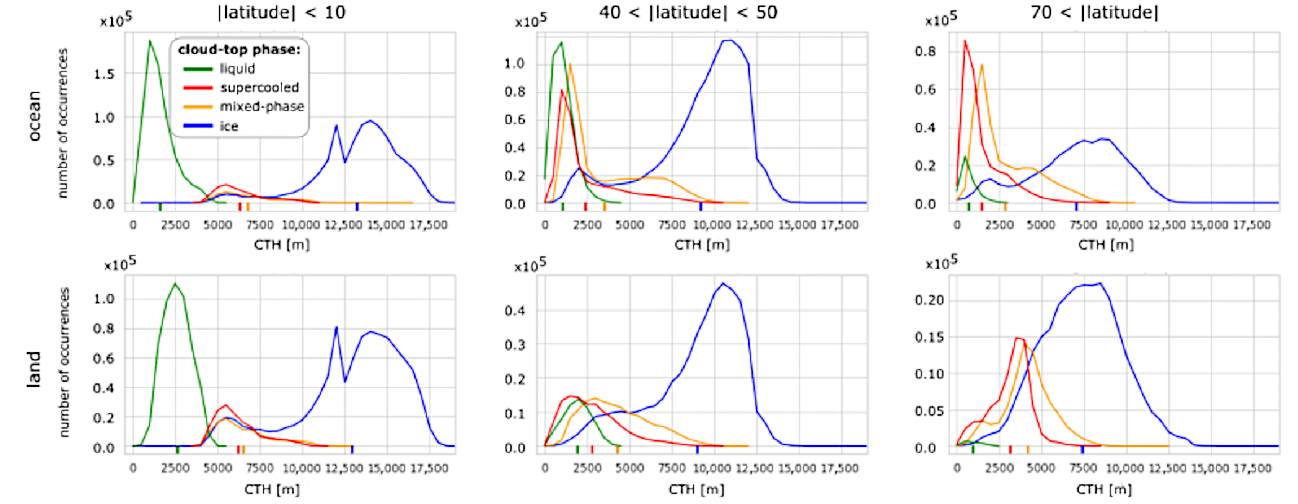
Figure 5. Number of occurrences of SEVIRI-like CTP as a function of CTH at different latitude regimes and land versus ocean, for CTH bins of 500m. The small vertical lines at the bottom of each plot show the average CTH for each